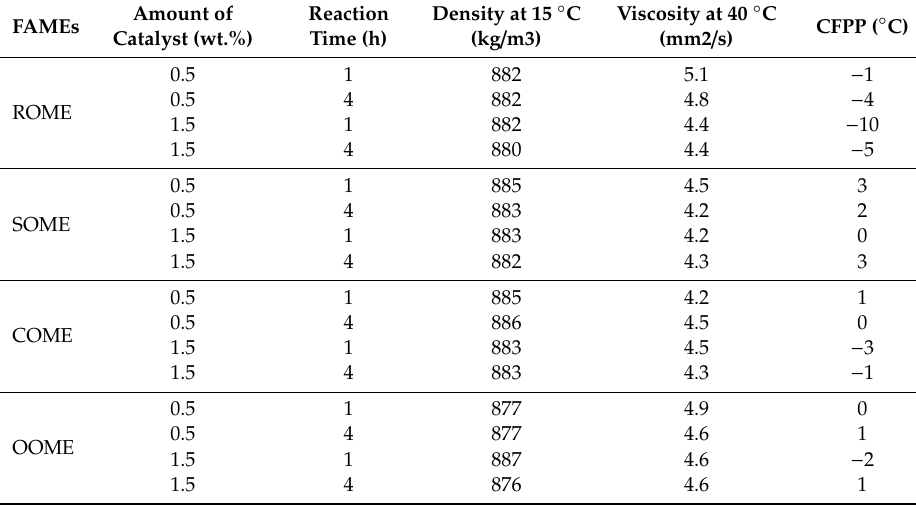
Table 1. The e ff ect of a catalyst KOH on the properties of ROME, SOME (methyl esters of